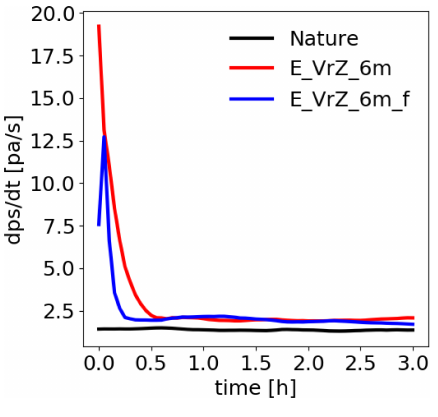
Figure 8. Domain-averaged surface pressure tendency at each minute during the 3h deterministic forecast starting at 15:00UTC for the nature run, E_VrZ_6m and